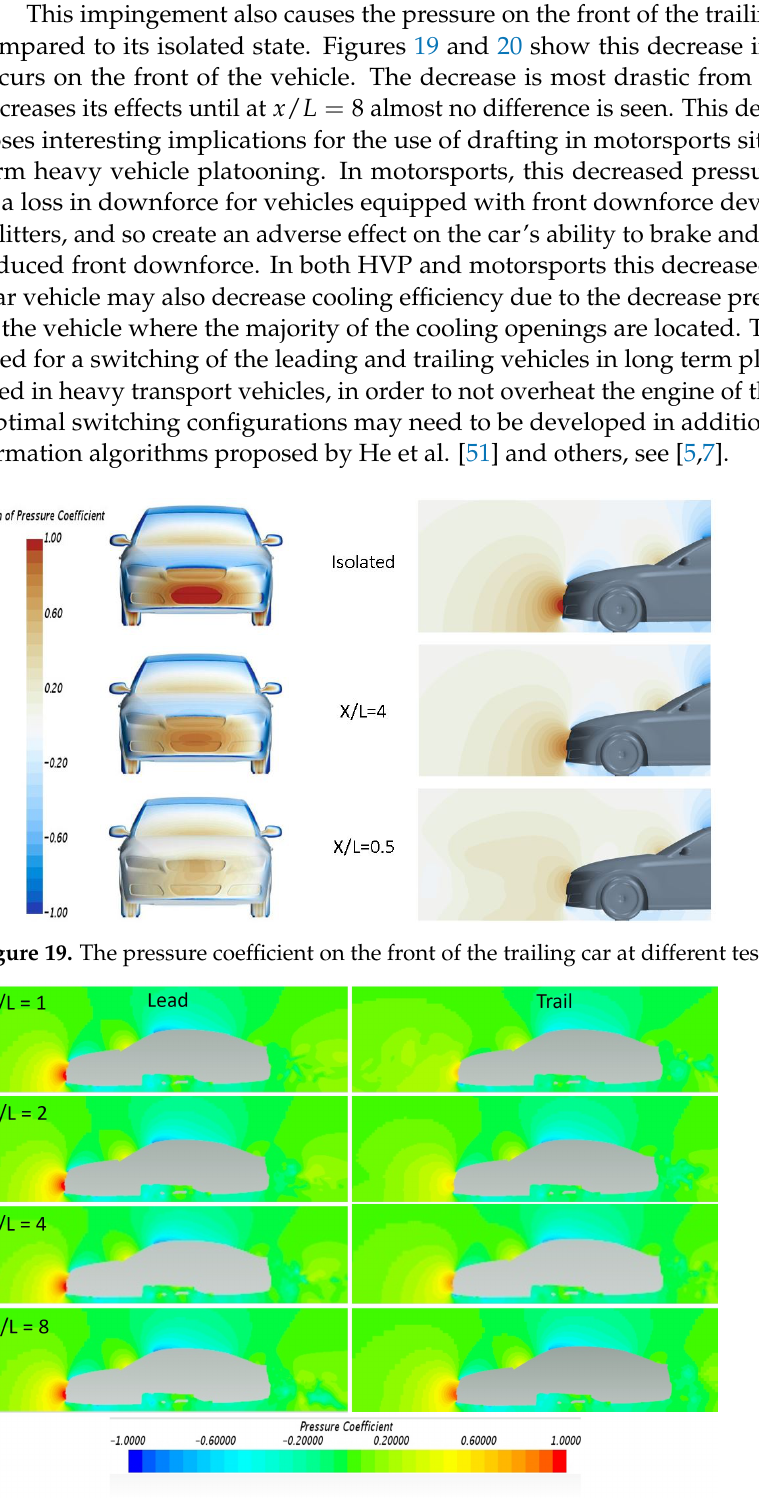
Figure 20. The pressure coefficient along the center plane on the leading and trailing